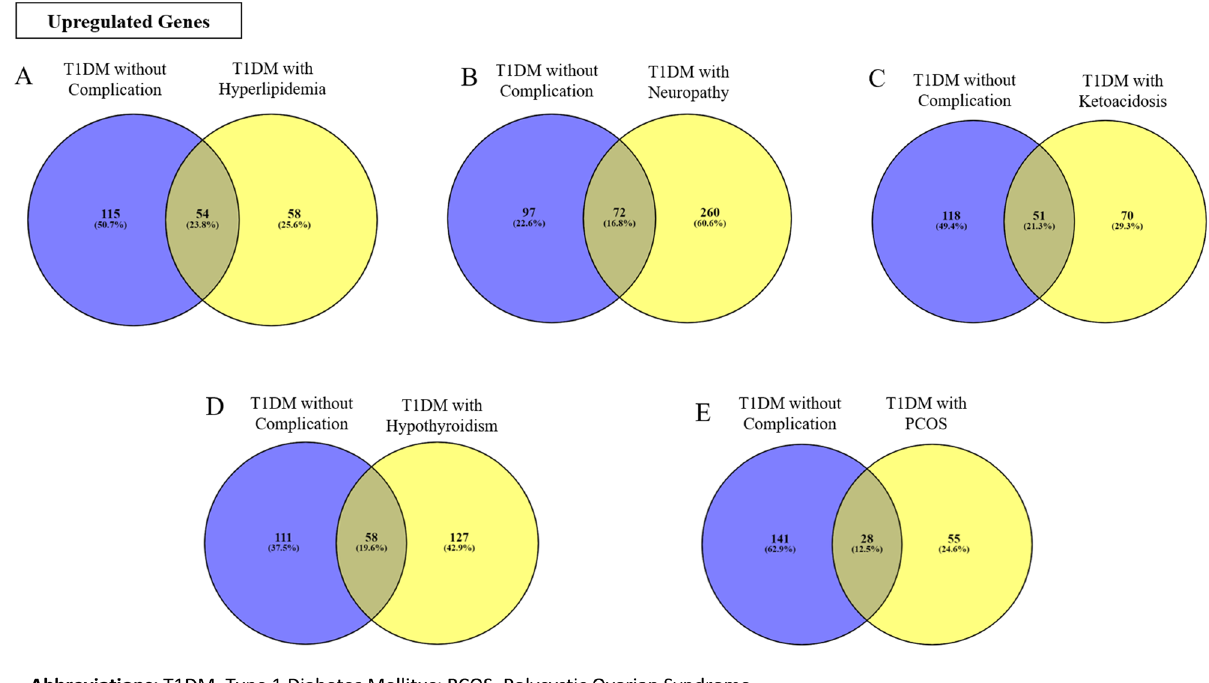
Figure 2. Upregulated and common DEGs between the T1DM without complications (blue circles) and T1DM with complication groups (yellow circles; ( A ) Hyperlipidemia, ( B ) Neuropathy, ( C ) Ketoacidosis, ( D ) Hypothyroidism and ( E ) Polycystic Ovarian Syndrome [PCOS]). Overlap between the two circles denotes the number and corresponding percentage of the common genes which was highest between T1DM without complications vs T1DM with hyperlipidemia (23.8%) and lowest for the PCOS group (12.5%).